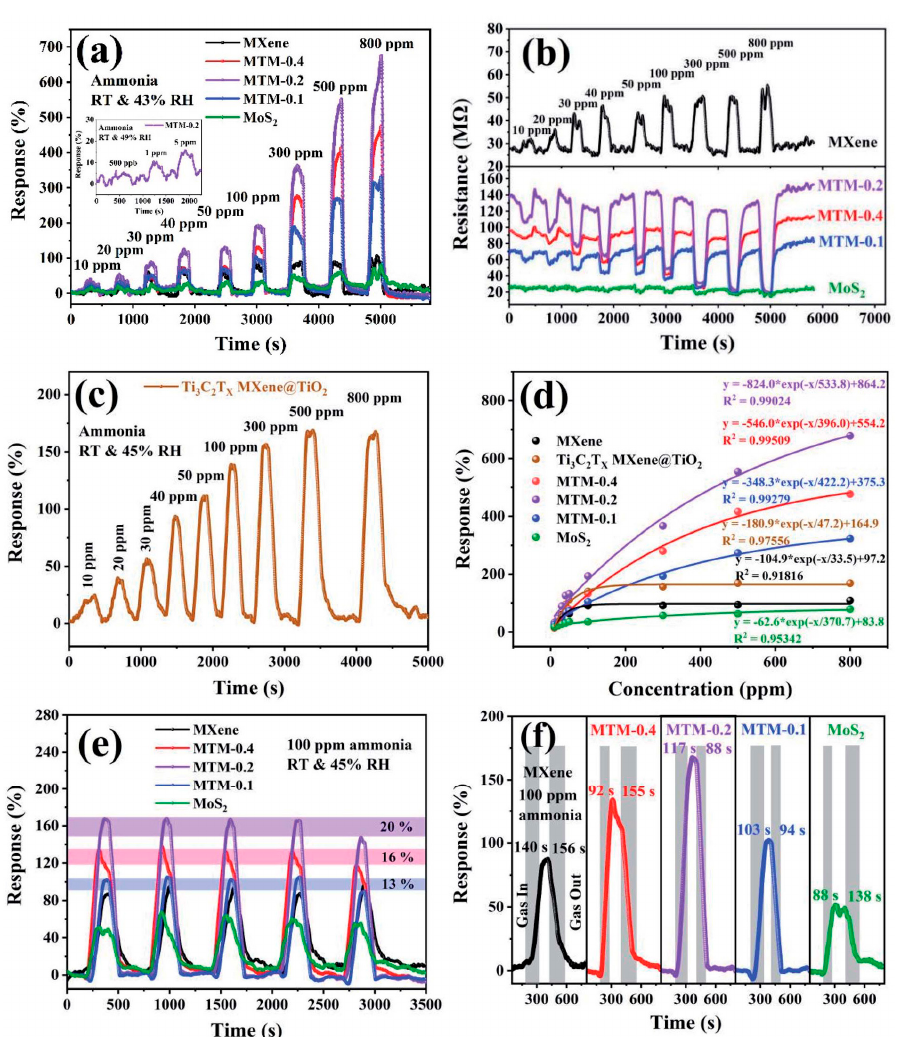
Figure 34. ( а ) Dynamic sensing characteristics of the prepared sensors to ammonia vapor at RT of 27 ° С and RH of 43%; ( b ) resistance of the prepared sensors to different concentrations of ammonia vapor; ( c ) dynamic sensing characteristics of the Ti 3 C 2 T x MXene@TiO 2 sensor to ammonia vapor at RT of 26 ° С and RH of 48%; ( d ) fitting equations of all prepared sensors between the ammonia re- sponse and gas concentration; ( e ) the reproducibility of the sensors to 100 ppm ammonia at RT of 27 ° С and RH of 45%; ( f ) the response and recovery times for 100 ppm ammonia at RT of 27 ° С and RH of 45%. Reprinted with permission from [152]. Copyright 2022: The Royal Society of Chemistry.